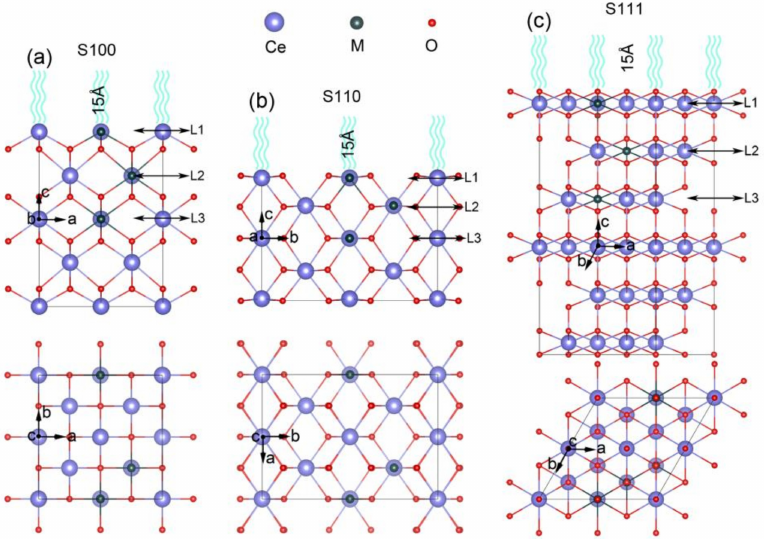
Figure 1. Side views (upper panel) and top views (lower panel) of modeled surfaces for M x Ce 1 − x O 2 . ( a ) 100-oriented slab labeled with S100, ( b ) 110-oriented slab labeled with S110 and ( c ) 111-oriented slab labeled with